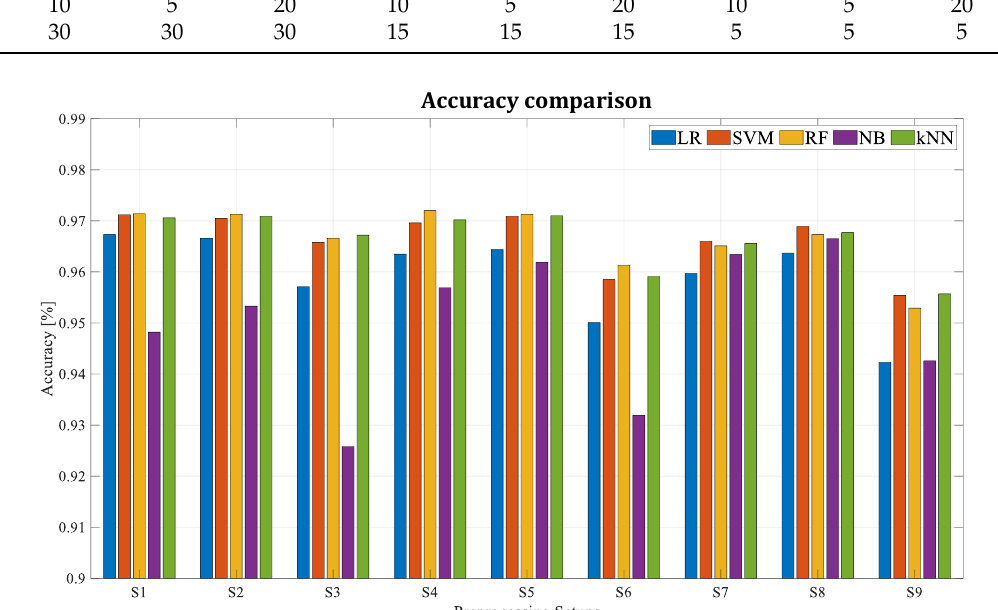
Figure 8. Accuracy for different algorithms and dataset configurations.